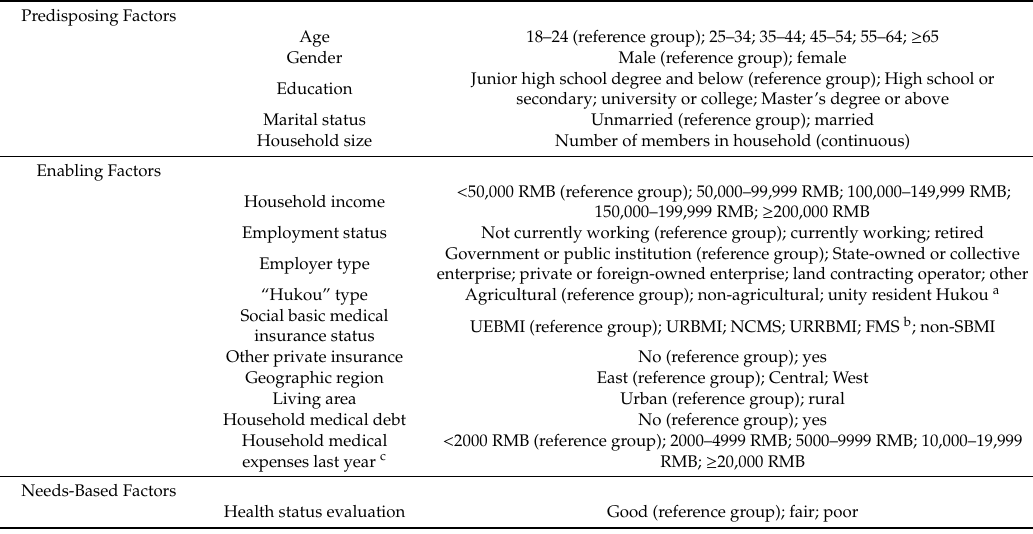
Table 1. Independent variables used in the logistic regression